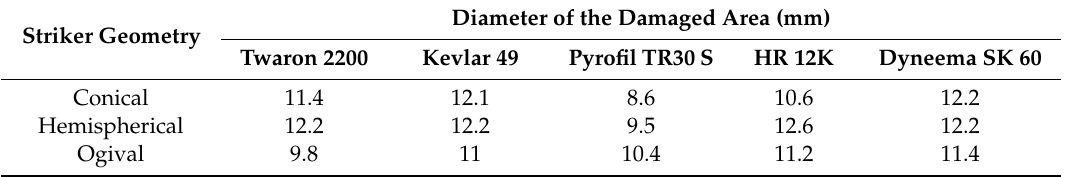
Table 5. Diameter of the damaged area on the first reinforcing layer from the side of the impact. Striker